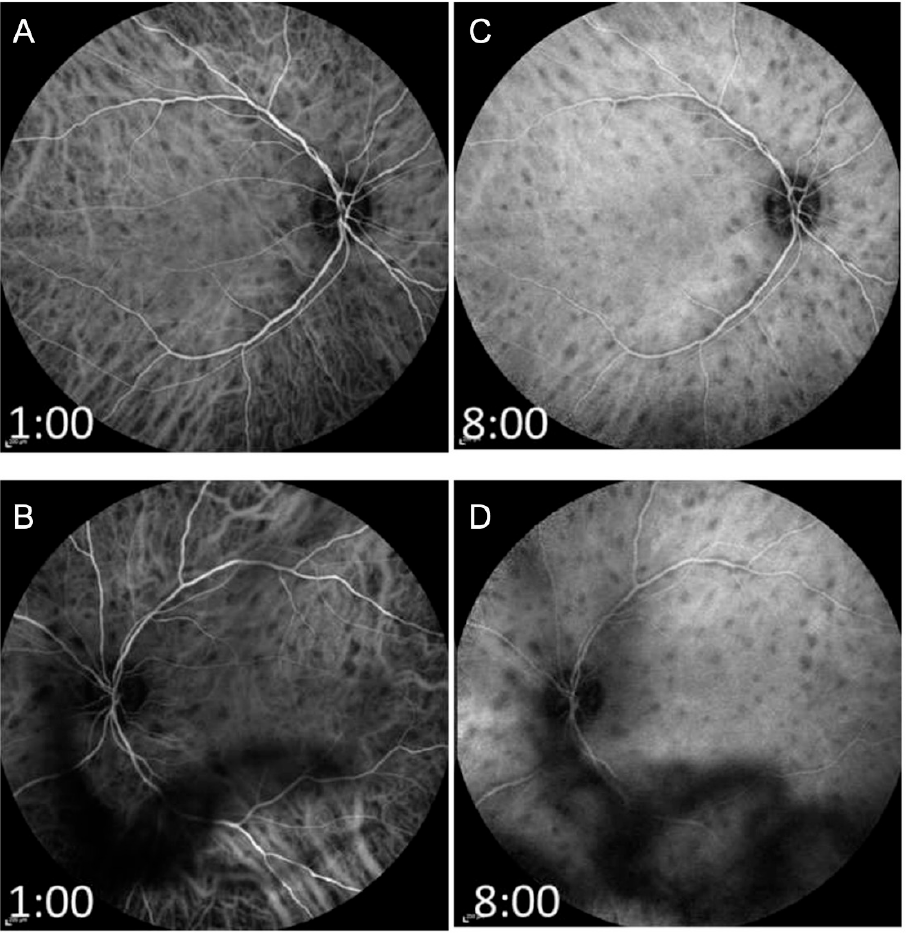
Figure 17. Indocyanine green angiography (ICGA) of the patient with Birdshot chorioretinopathy described in Figures 14–16 is shown. The ICGA of both fundi in the early phase ( A , B ), and the late phase ( C , D ) (right and left eyes, respectively) show numerous evenly distributed and symmetric hypocyanescent spots throughout the fundus of both eyes, suggestive of choroidal inflammation.